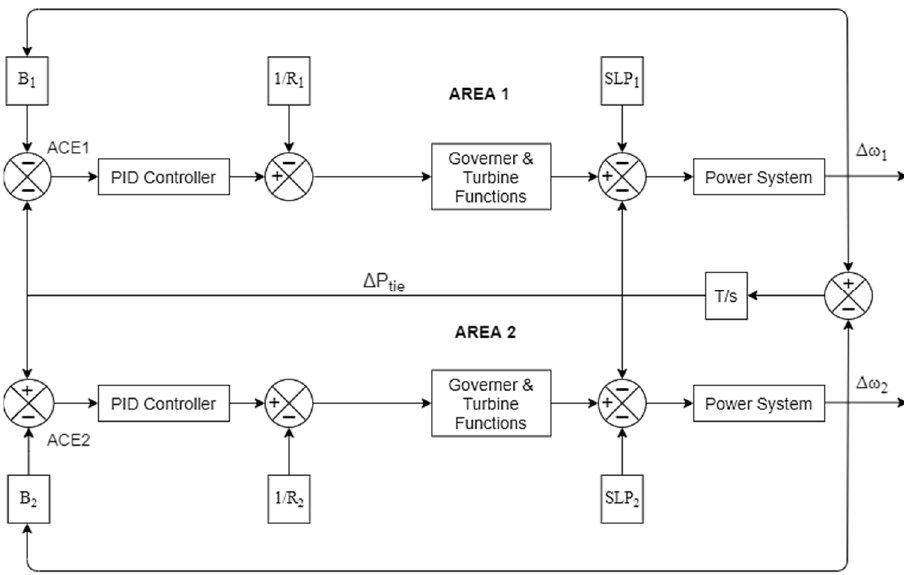
Figure 1. Block diagram of two-area thermal system.